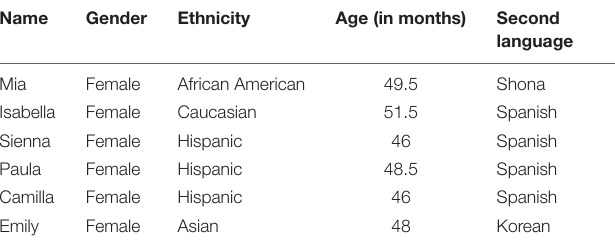
TABLE 1 | Description of